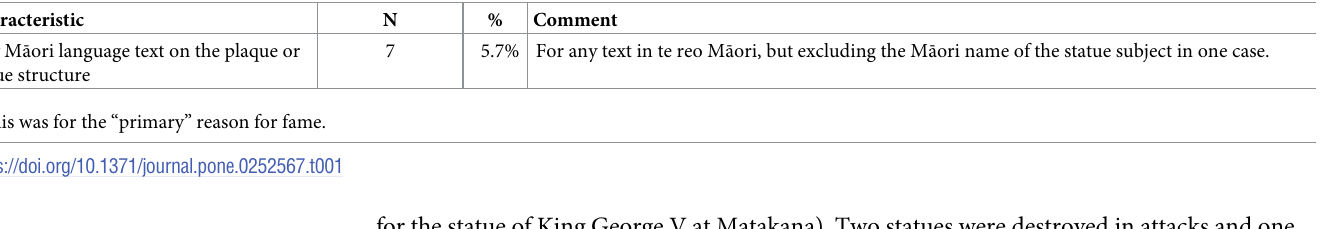
(Table 3). Risk of attack was relatively high for: royalty (50%), military personnel (33%),